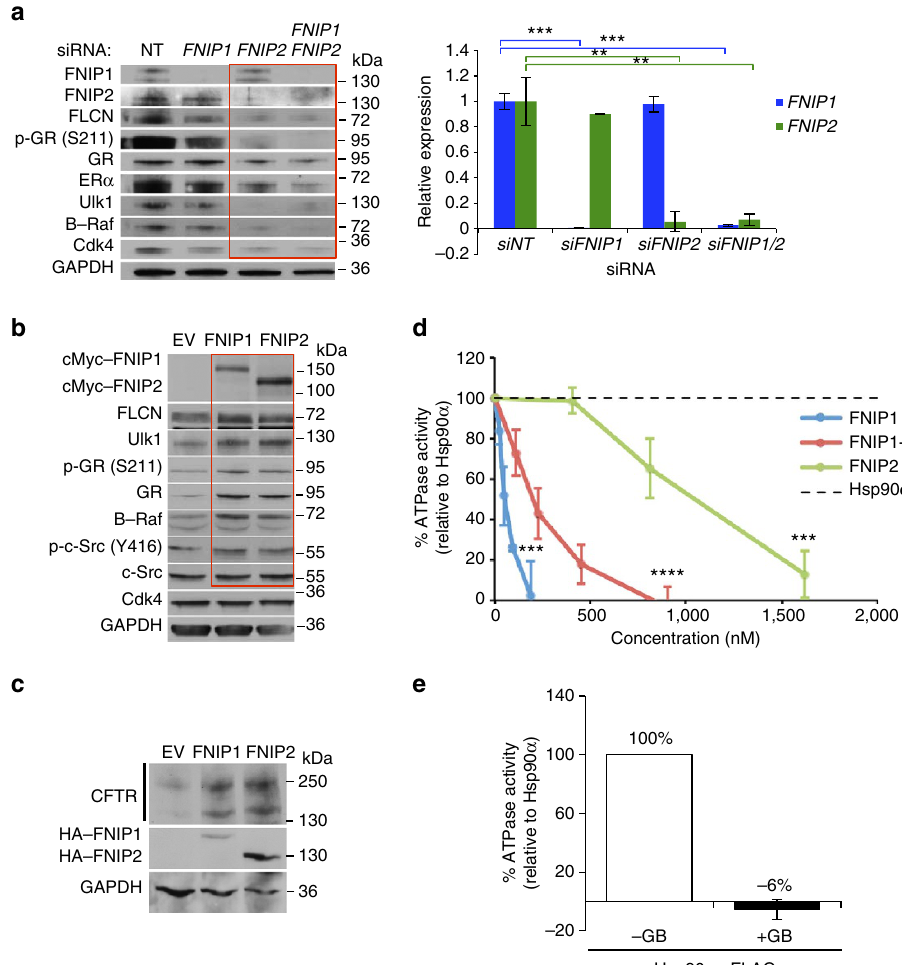
Figure 4 | FNIPs co-chaperones inhibit Hsp90 chaperone cycle and facilitate chaperoning of the clients. ( a ) Effect of siRNA knockdown of FNIP1 and FNIP2 on Hsp90 clients. Stability and activity of the indicated clients were assessed by immunoblotting. Densitometry of the western blotting for FNIP1 and FNIP2 is represented as mean ± s.d. A Student’s t -test was performed to assess statistical significance (** P o 0.005 and *** P o 0.0005). ( b ) Transient overexpression of cMyc-tagged FNIP1 or FNIP2 in HEK293 cells and their impact on levels of Hsp90 clients was assessed by immunoblotting. Empty vector (EV) was used as a control. ( c ) HEK293 cells were co-transfected with CFTR and indicated HA–FNIP1 and HA–FNIP2 constructs. After 24h, CFTR and FNIPs–HA were detected by immunoblotting; GAPDH was used as loading control. Empty vector (EV) was used as a control. ( d ) In vitro ATPase activity of Hsp90 a –FLAG isolated from PC3 cells. Inhibitory effects of purified HA–FNIP1, FNIP1-D–HA or HA–FNIP2 on ATPase activity of Hsp90 a –FLAG. All the data represent mean ± s.d. A Student’s t -test was performed to assess statistical significance (*** P o 0.0005 and **** P o 0.0001). ( e ) ATPase activity of Hsp90 a –FLAG from d was inhibited by addition of 10 m M GB. All the data represent mean ± s.d. A Student’s t -test was performed to assess statistical significance (**** P o